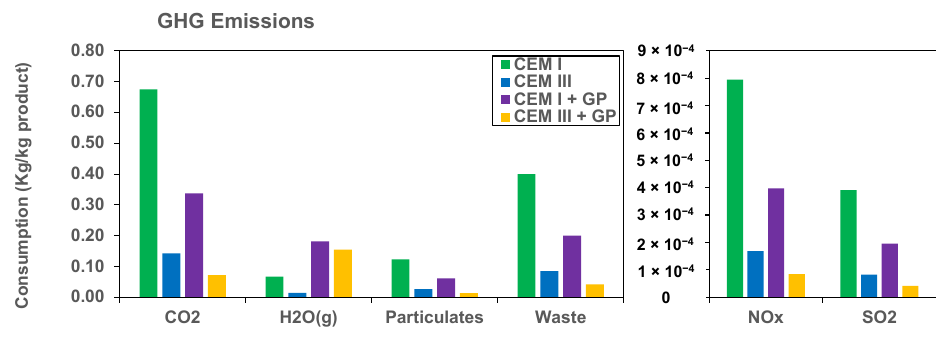
Figure 8. GHG Emissions results.